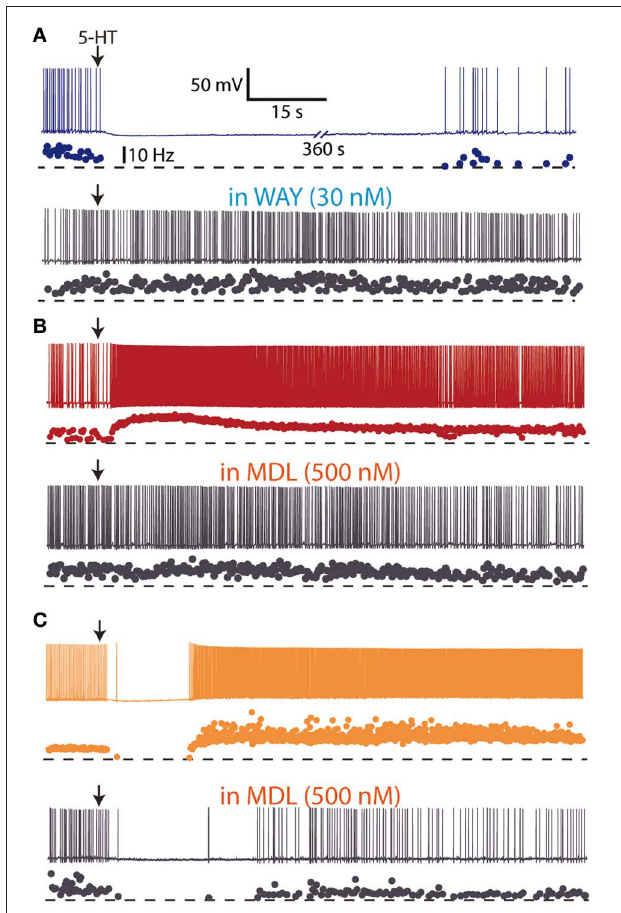
FIGURE 3 | Hyperpolarizing and depolarizing effects of 5-HT in layer V pyramidal neurons of medial prefrontal cortex slices from mice. (A) Focal (local) application of 5-HT (100 μ M) elicited a hyperpolarizing response which was blocked by the 5-HT 1A antagonist WAY 100635 (30nM), suggesting the expression of 5-HT 1A receptors. (B) Focal application of 5-HT (100 μ M) elicited a depolarizing response which was blocked by the 5-HT 2A antagonist MDL 11939 (500nM), suggesting the expression of 5-HT 2A receptors. (C) Focal application of 5-HT (100 μ M) elicited a biphasic response sensitive to the 5-HT 2A antagonist MDL 11939 (500nM). Redrawn from Avesar and Gulledge (2012) with permission from A.